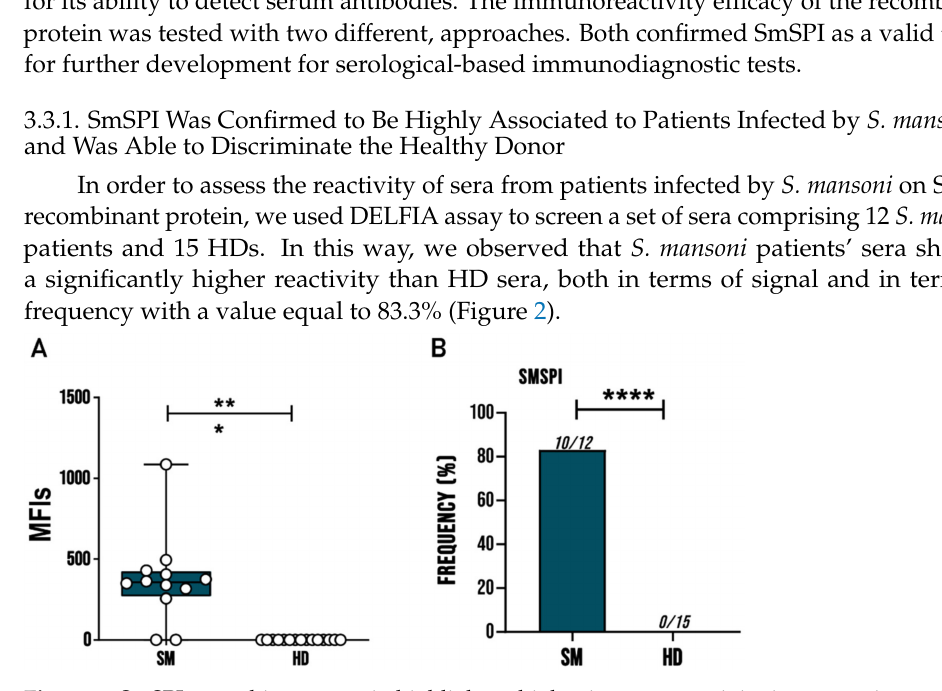
Figure 2. SmSPI recombinant protein highlights a higher immunoreactivity in sera patients affected by S. mansoni than in that of healthy donors (HDs). ( A ) Whisker plots comparing mean fluorescence intensity (MFI) of SmSPI recombinant protein tested with sera of 15 HDs and 12 Schistosome patients (SM). Each dot represents the MFI of a single patient. Asterisk denotes statistical significance (Student’s t test, p < 0.01). ( B ) Recognition frequency. Each serum was tested four times. Asterisk denotes statistical significance (Fisher exact test, p < 0.01). *** p < 0.001, **** p <